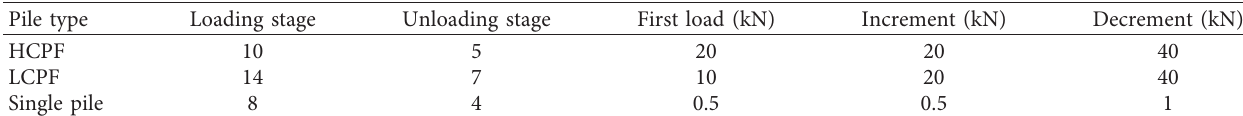
Table 3: Information of the test